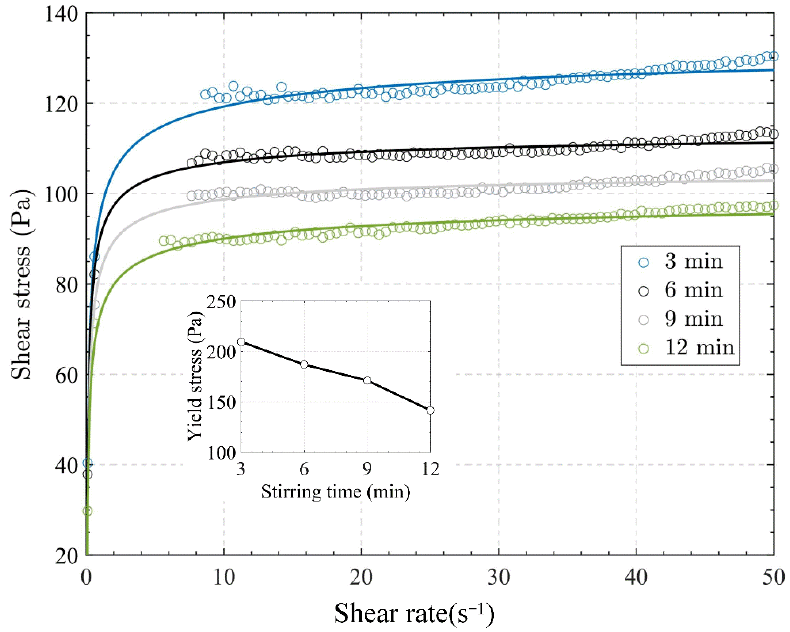
Figure 8. Flow curves of samples with different stirring times: shear rate vs. shear stress and the yield stress were presented as a function of stirring time in the inset.